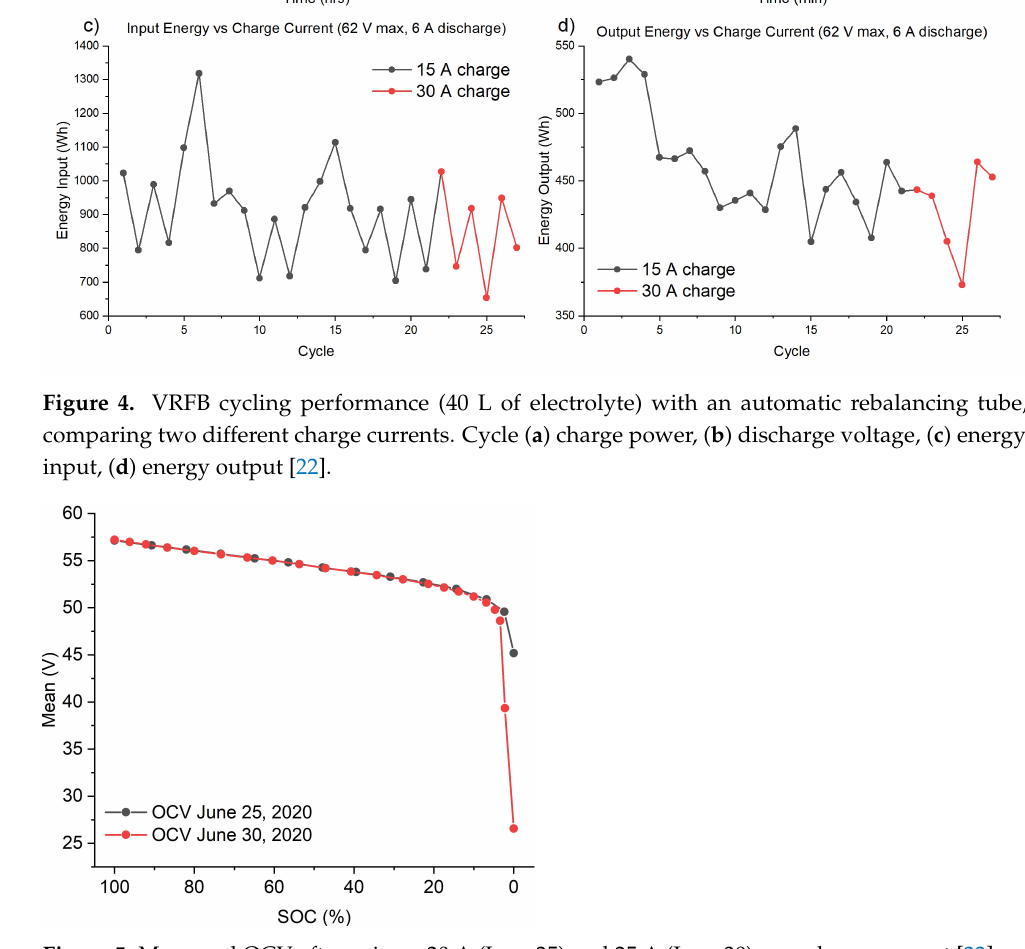
Figure 5. Measured OCV after using a 20 A (June 25) and 25 A (June 30) max charge current [22]. These experiments also allow us to observe the relationship between terminal and open circuit voltages. The previously obtained OCV values are compared to the terminal voltages observed during discharge in Figure 6. The current applied during the discharge process gives rise to overpotentials, causing the OCV to be approximately 0.88 V higher than the terminal